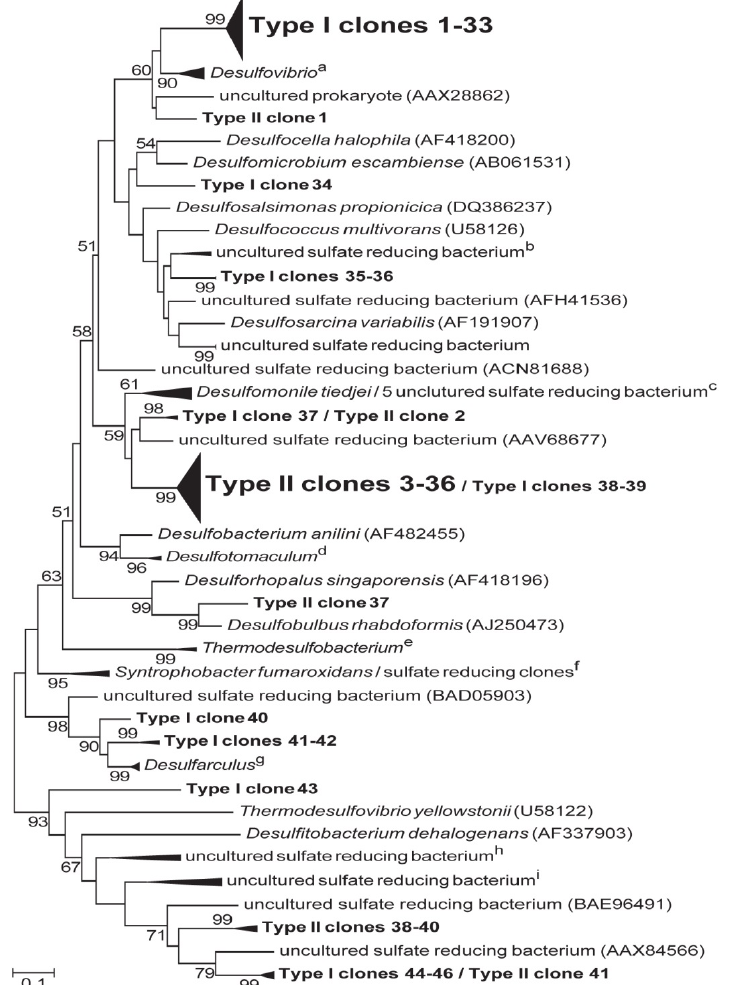
Figure 4. Phylogenetic tree based on translated amino acid sequences of PCR-amplified dissimilatory sulfite reductase dsrA genes retrieved from type I and type II stromatolites. Tree shows distributions of clones related to known sulfur-reducing bacteria and closely related sequences obtained from the GenBank database. GenBank accession numbers are shown in parentheses for non-collapsed branches and are as follows for collapsed branches: a AFA43406, EU127914, BAB55577, AFA43404, BAB55579, AB061543; b ACI31420, ABK90679; c ABK90745, AF334595, ABK90741, ABK90691, AAO61116, ABK90759; d AF271769, AF273029; e AF271771, AF334598; f AF418193, CAY20641, CAY20696; g YP003806924, AAK83215, AF334600; h AEX31202, CAJ84858, CAQ77308; i ACJ11472, CAJ84838, ACJ11485, ABK90809. The tree was constructed using the maximum likelihood method in MEGA 5 with values at nodes representing bootstrap confidence values with 1000 resamplings. Bootstrap values are shown for branches with more than 50% bootstrap support. Scale bar represents 0.1 substitutions per